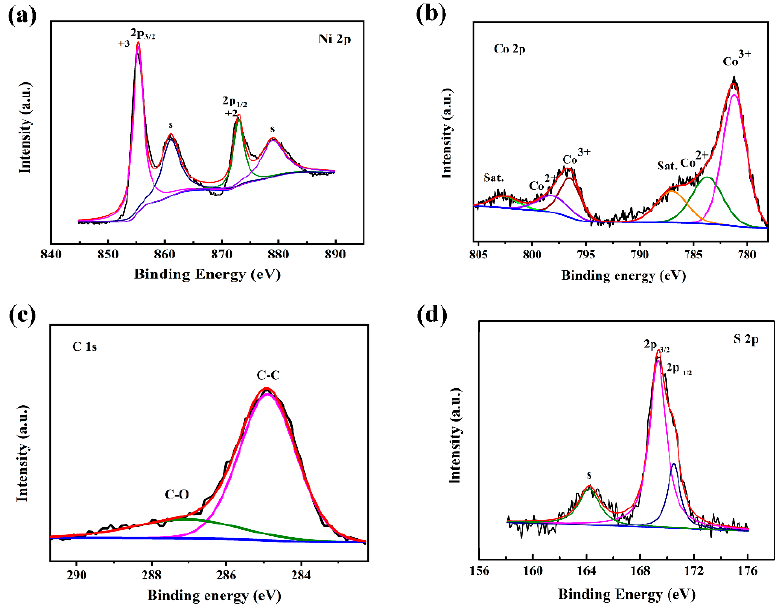
Figure 4. XPS wide spectrum ( a ) Ni 2p ( b ) Co 2p ( c ) C 1s ( d ) S 2p. The color curves are peak fitting curves.